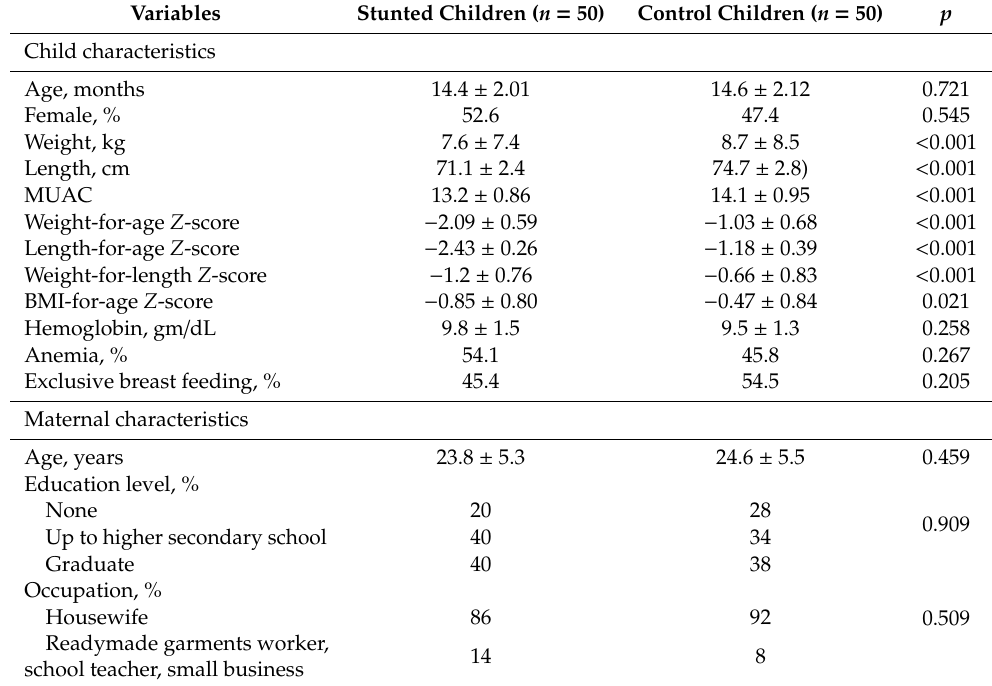
Table 1. Socio-demographic parameters among stunted and control children at